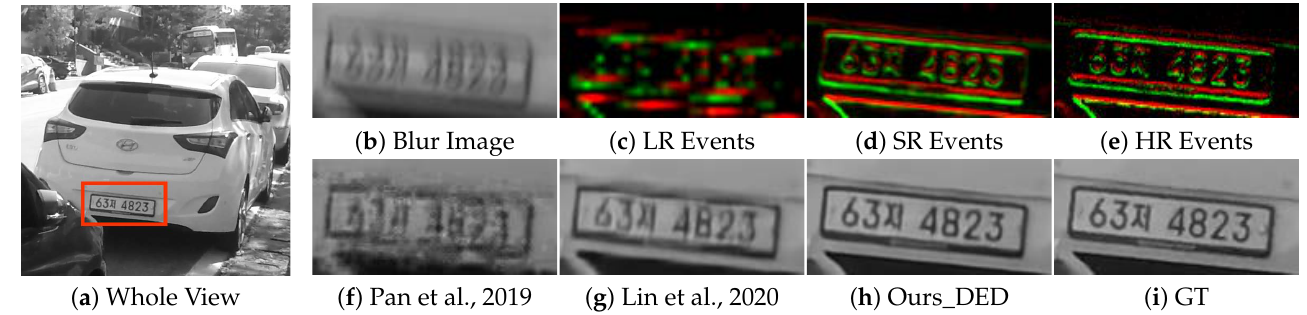
Figure 1. Results of image deblurring when facing low-resolution events. Methods proposed in [14,15] are presented in terms of their image deblurring potential and both of them aim to process events and intensity images of the same resolution. ( a ) Whole View; ( b ) Blur Image; ( c ) LR Events; ( d ) SR Events; ( e ) HR Events; ( f ) Pan et al., 2019; ( g ) Lin et al., 2020; ( h ) Ours_DED; ( i ) GT. When they confront the events ( c ) whose spatial resolution is 4 times lower than that of the blurry image, their performance becomes worse, as shown in ( f , g ). Facing these two kinds of degraded data, this paper tends to update the intensity image and events alternately, and finally attains a higher quality intensity image ( h ) and events ( d